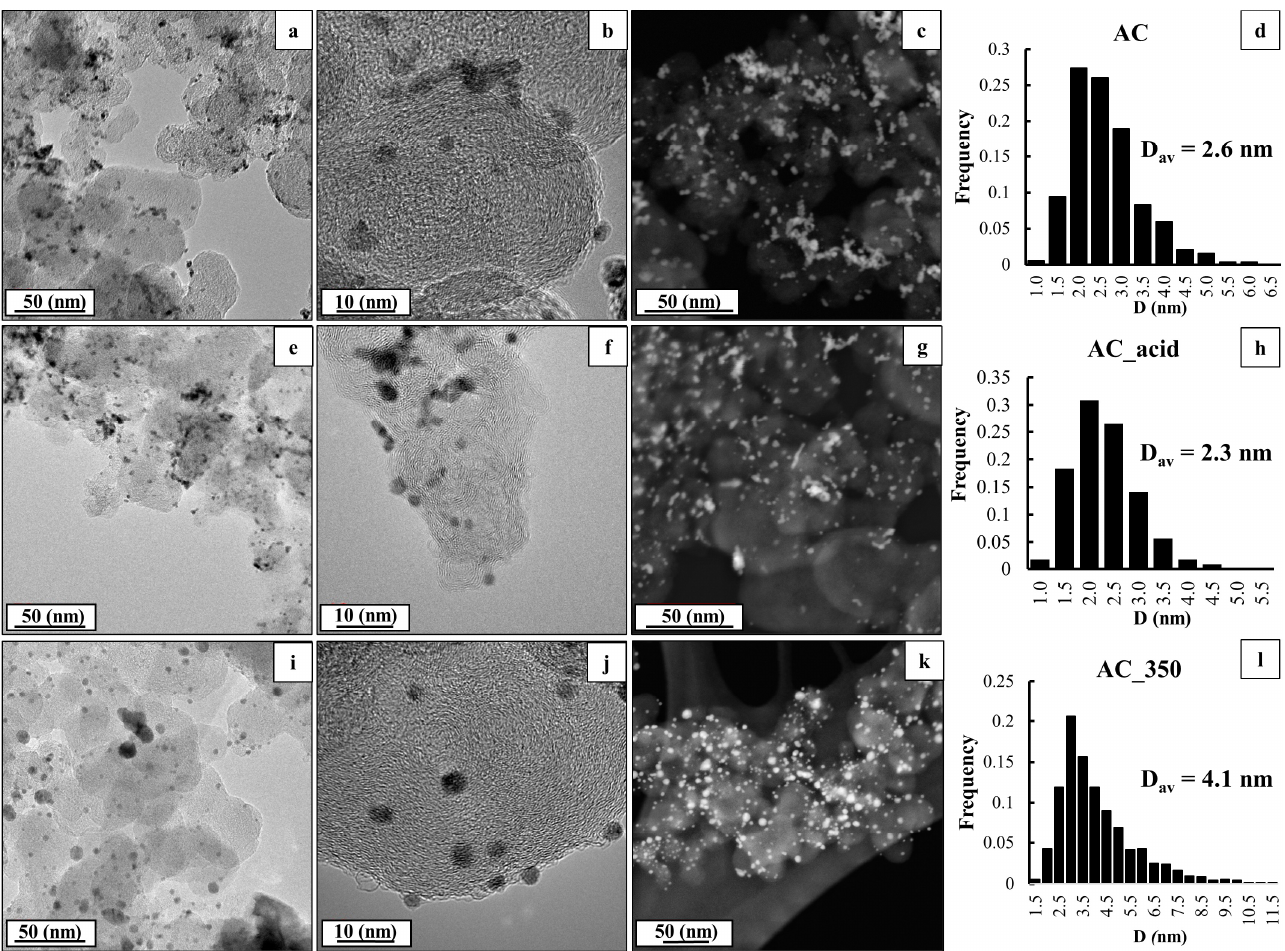
Figure 2. The TEM micrographs of the PtCu/C samples ( a , b , e , f , i , and j ); the STEM micrographs ( c , g , and k ); and the histograms of the NPs’ size distribution ( d , h , and l ) before and after the treat- ment.